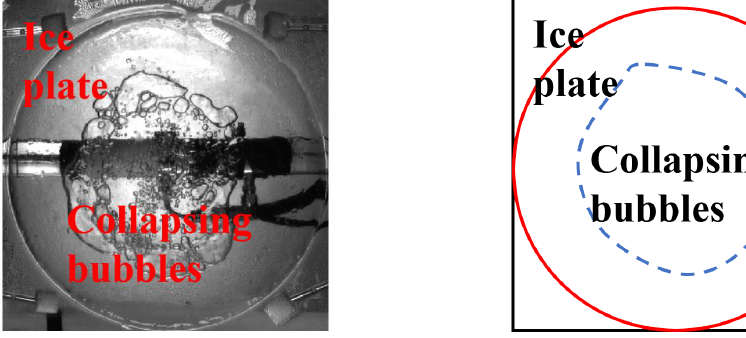
Figure 12. No crack pattern when H = 1.68, T = 0.26.